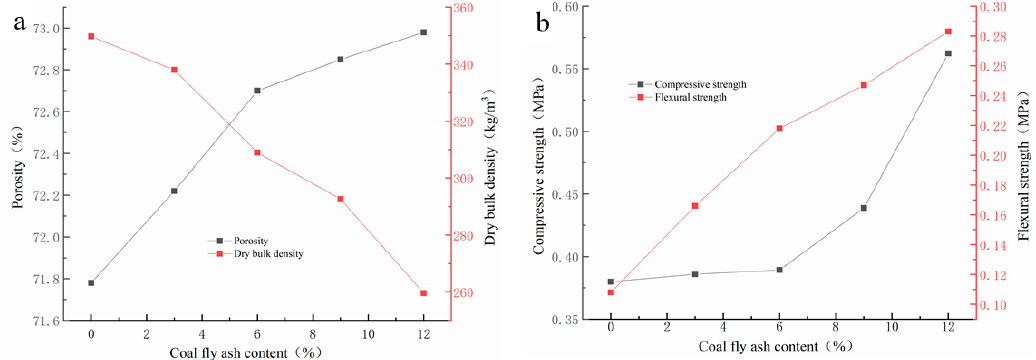
Figure 3. The trend of physical properties versus the addition of CFA: ( a ) porosity; ( b ) compressive strength.